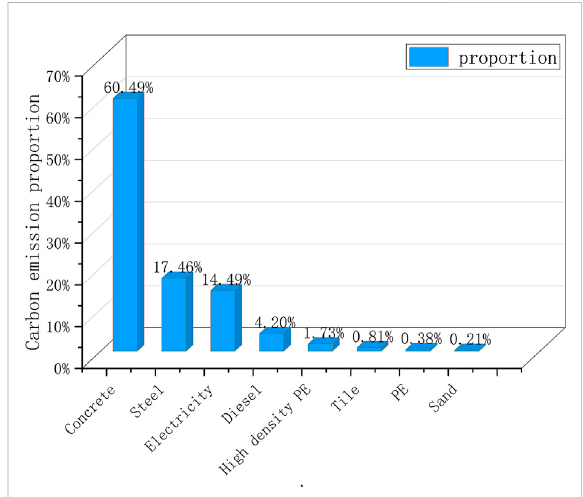
FIGURE 5 Carbonemissionproportionofdifferentmaterialsandenergy used in tunnel construction.